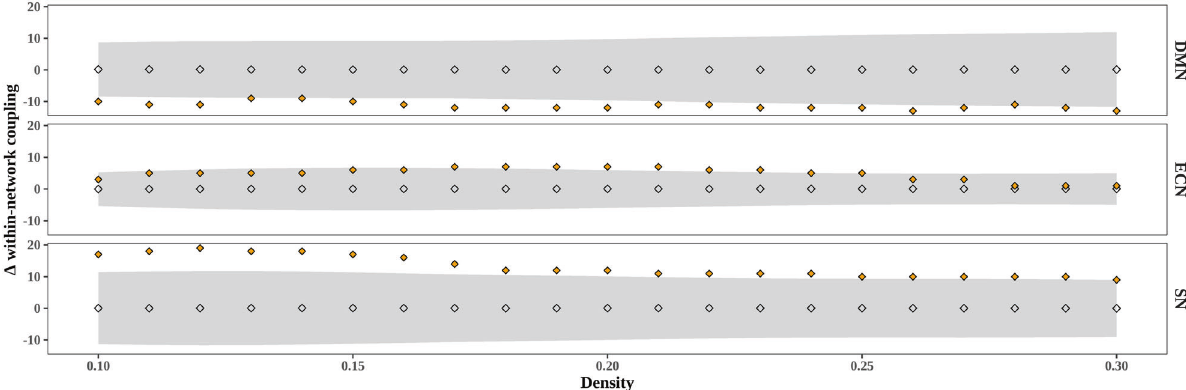
Fig. 1 Difference in within-network maturational coupling between preterm-born infants exposed to high versus low stress (median split) across density levels. Positive values show high stress >low stress and negative values show low stress >high stress. Gray diamonds depict the permutation distribution of average maturational coupling, gray bands depict 95% con fi dence interval, and orange diamonds depict the group-level difference